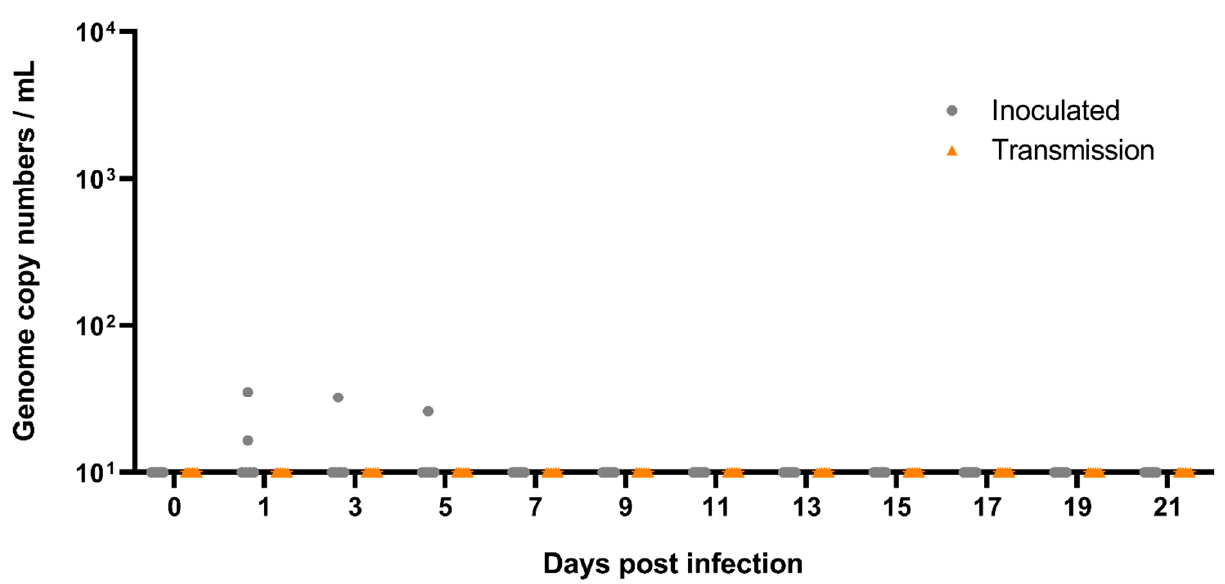
Figure 5. Viral shedding from rectal swab samples of the Rousettus bats following infection with A/bat/Egypt/381OP/2017 (H9N2). Viral shedding was monitored by RT-qPCR from rectal swabs. Swabs of six inoculated animals (grey dots) and six contact animals (orange triangles) were taken individually every other day. Samples below 10 viral genome copy numbers per mL (equivalent to Ct 39.2) were considered negative. DPI = Days post infection.